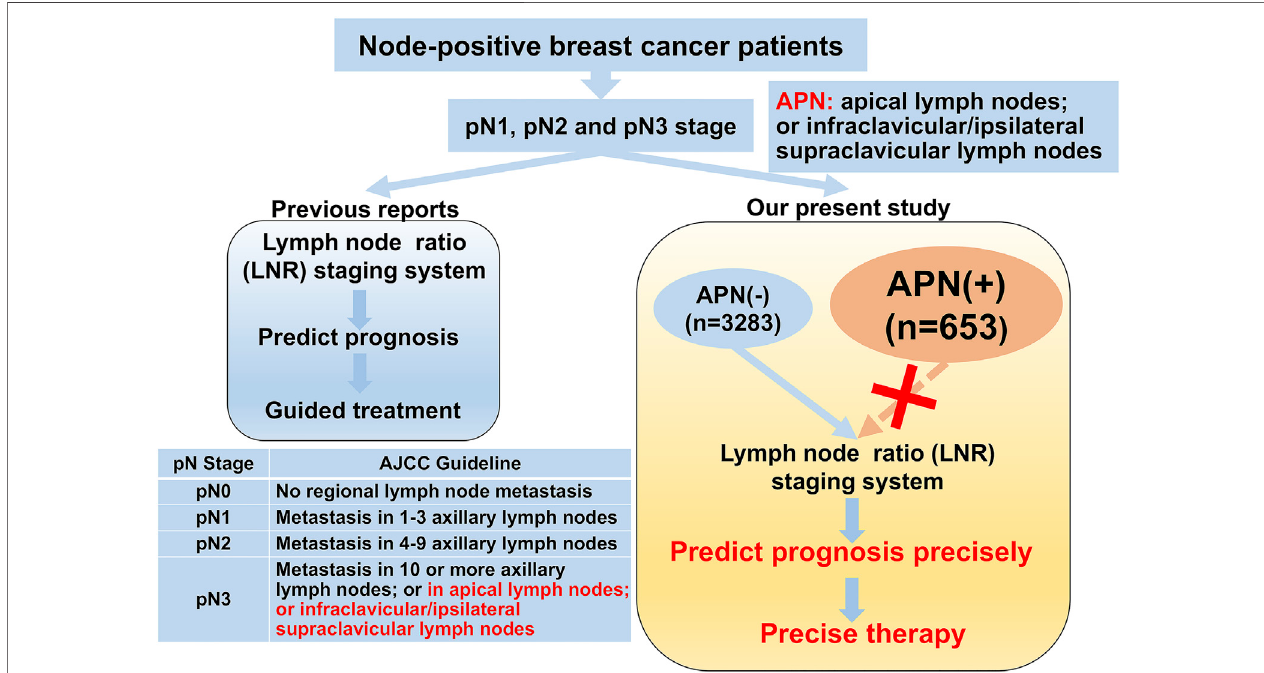
FIGURE 1 | Graphical abstract of the lymph node ratio system.